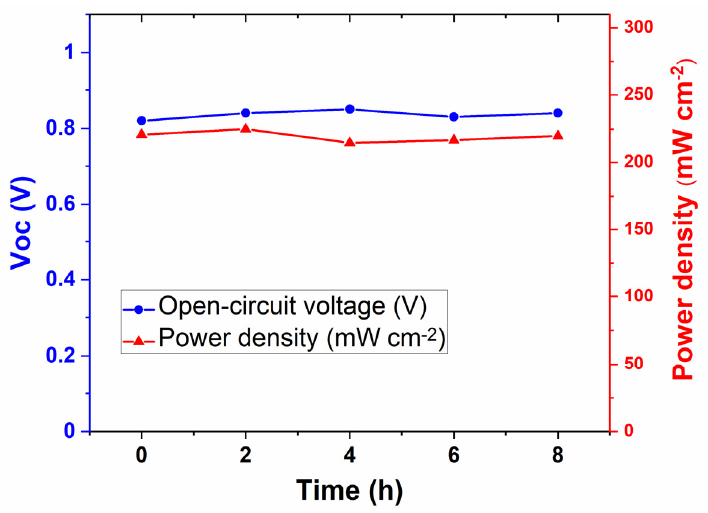
Figure 8. Short-term stability test of the printed single-layer cell sintered at 900 °C under open- circuit conditions. The power density measurements were carried out with an interval of 2